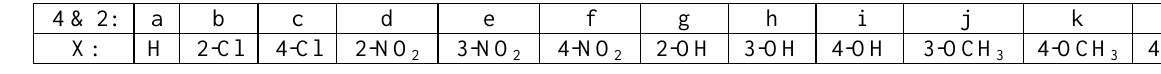
Table 2. Structure of compounds